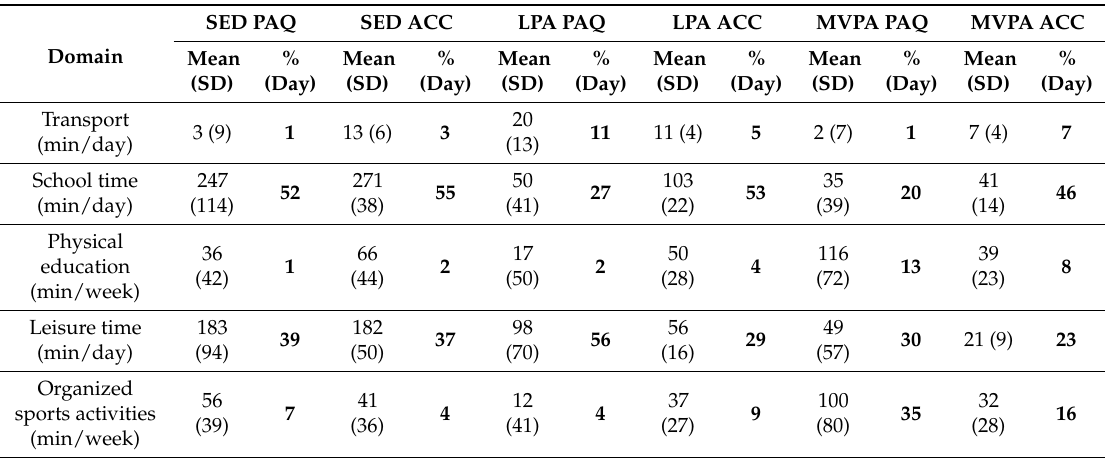
Table 2. Average duration and proportion of self-reported and objectively measured physical activity (PA) in different domains in children ( n = 207).